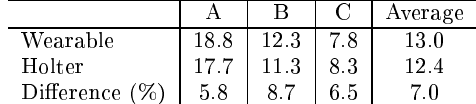
Table 3: Comparison of RR50 (Sample/min)